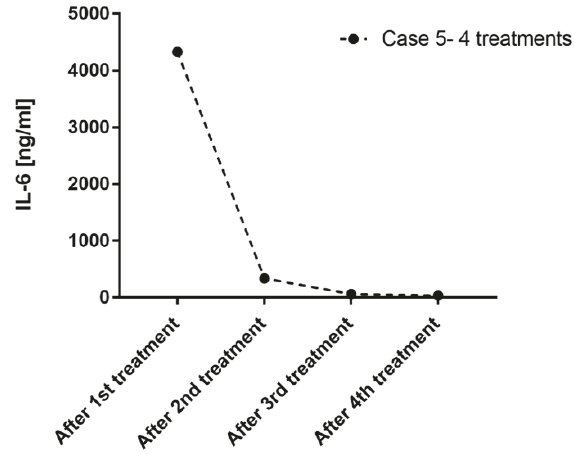
Figure 3: Course of IL-6 during Cytosorb treatment in Case 5. Values are shown after the first Cytosorb treatment, and then after every 24h until the